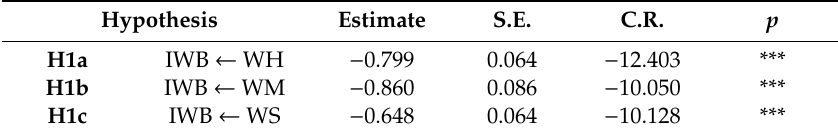
Table 4. Direct E ff ects (Path model results).